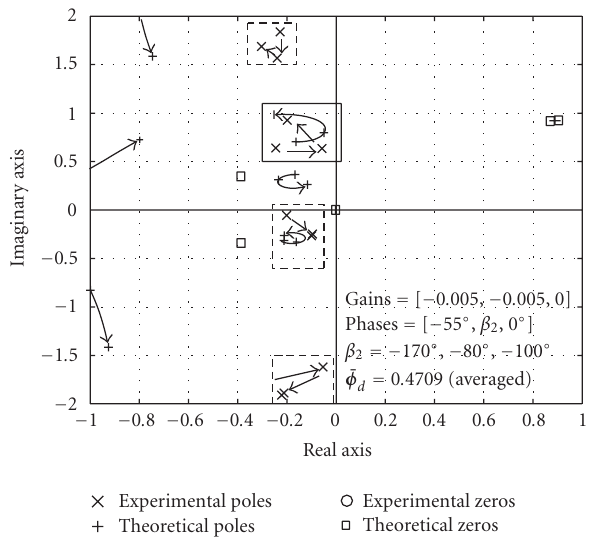
Figure 14: Closed-loop root locus for harmonic 2 with varying phase.